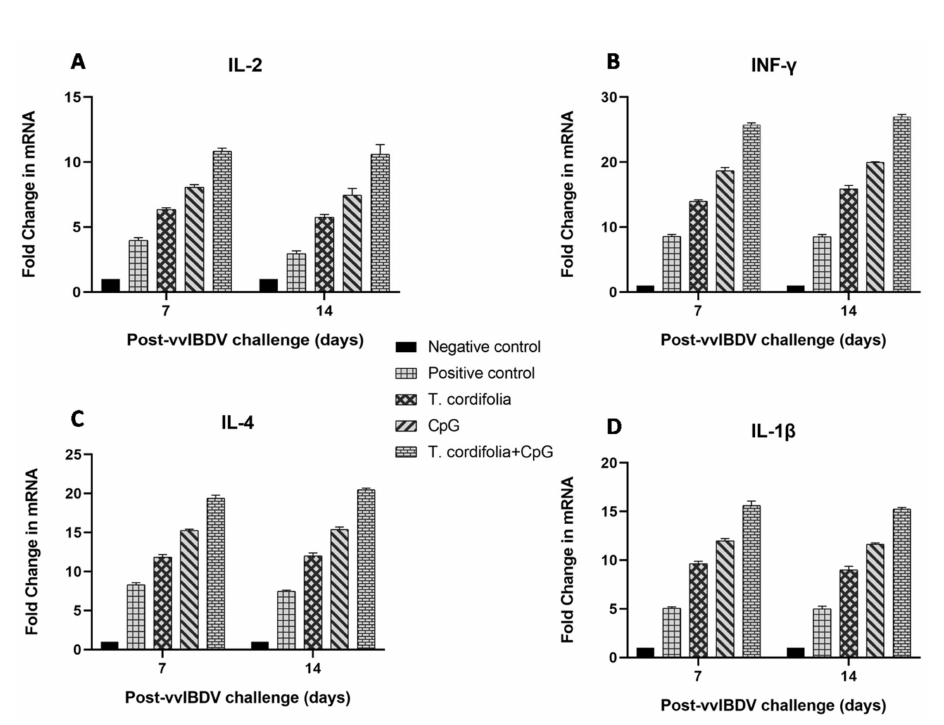
Figure 2. ( A – D ). Quantitative real-time PCR analysis of immune response gene transcripts in PBMCs ex vivo in SPF WL chickens 7 and 14 days post-vvIBDV challenge. The result is expressed as fold change in the immune response gene transcripts relative to the control